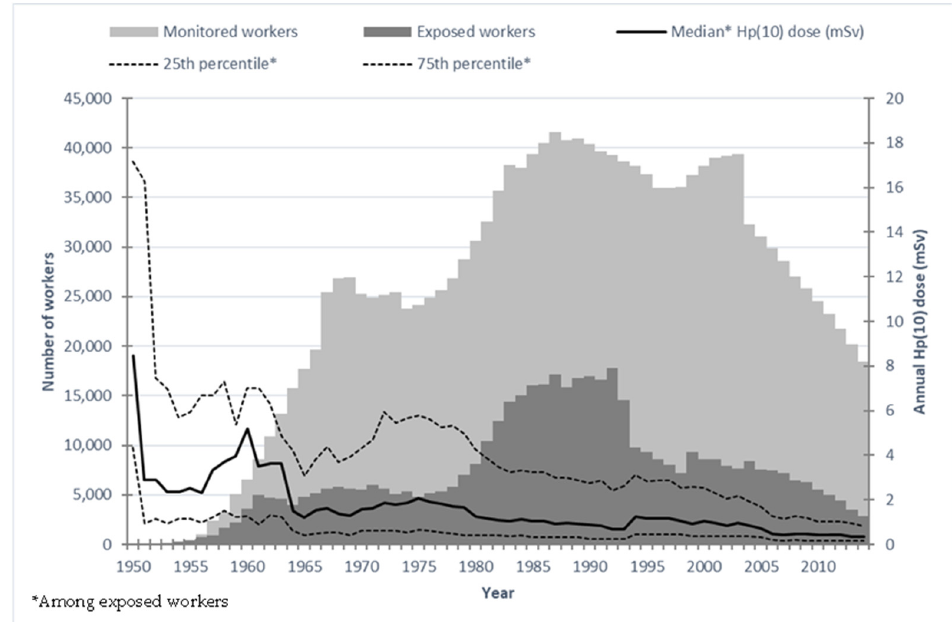
Figure 1. Distribution of monitored and exposed workers with median Hp(10) dose in milliSievert (mSv) by calendar year in SELTINE.